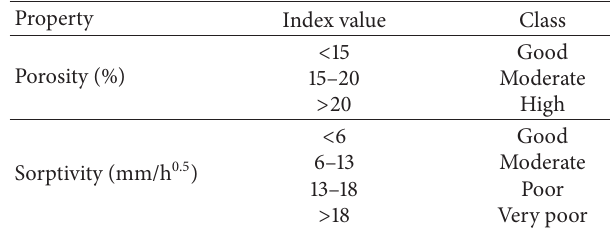
Table 5: New suggested indexes for porosity and sorptivity in recycled aggregate